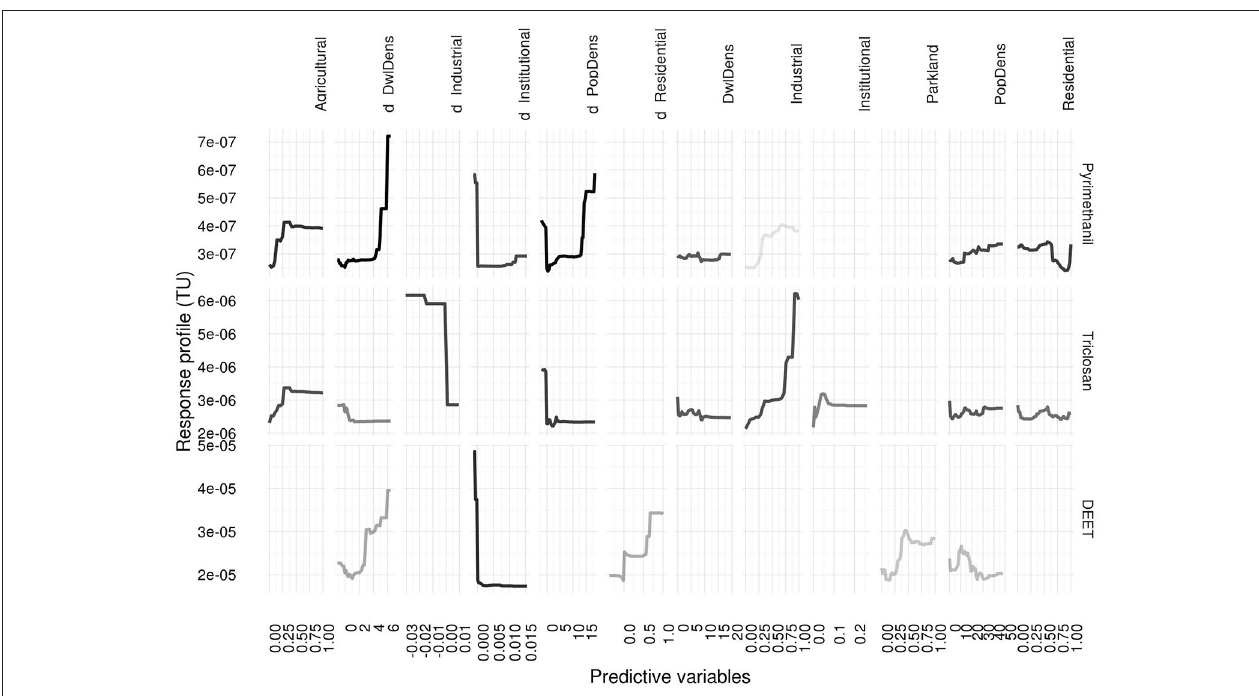
FIGURE 6 | Modeled partial dependence of pyrimethanil, triclosan, and DEET in toxic units (TU) on important predictor variables. Marginal response is shaded in proportion to the change in MSE in the final model, hence darker shading indicates more important variables. Note different response scales apply to each